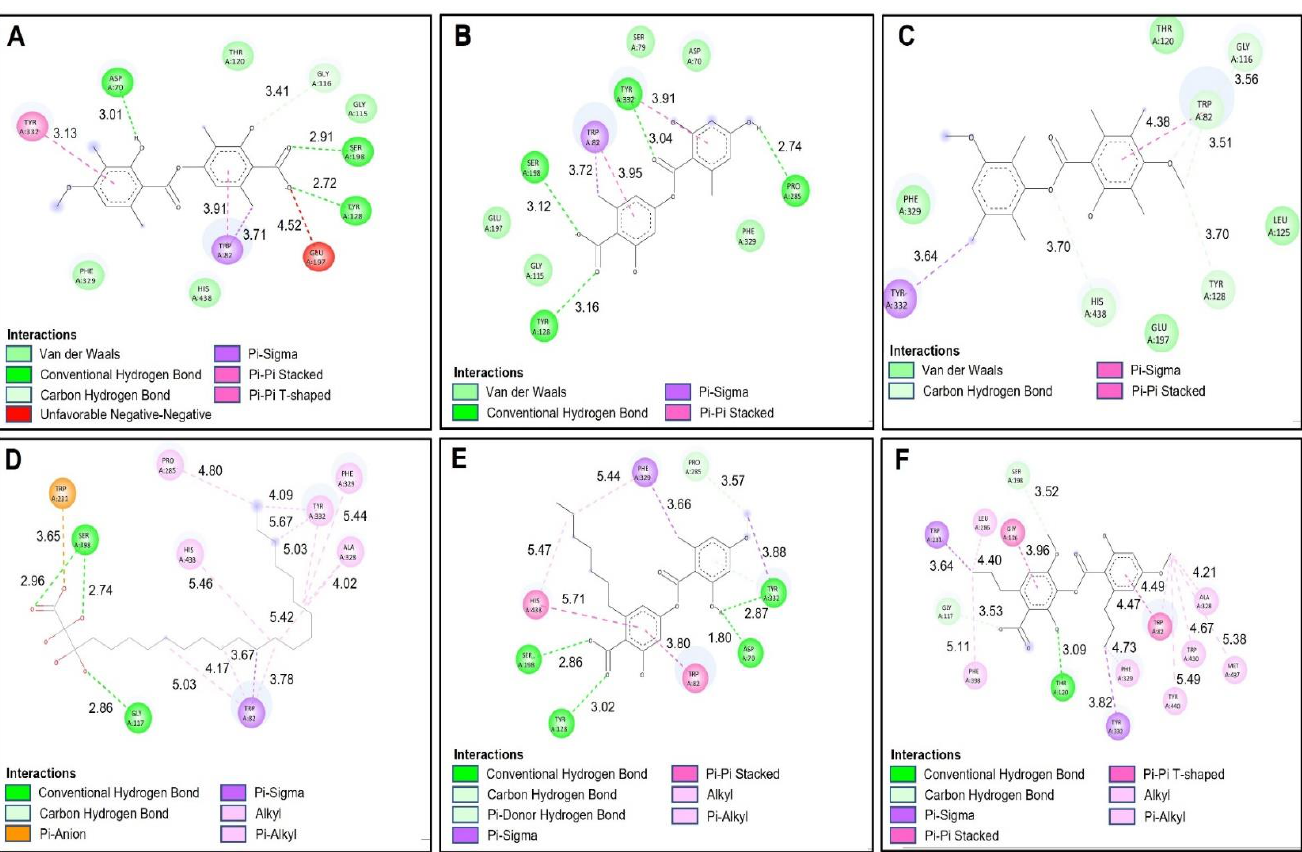
Figure 6. Two-dimensional diagram of compounds from Lecania brialmontii, Pseudephebe pubescens and Sphaerophorus globosus extracts and residues of the human butyrylcholinesterase (hBChE) catalytic site; ( A ) Barbatic acid at the catalytic site; ( B ) Lecanoric acid at the catalytic site; ( C ) Brialmontin 2 at the catalytic site; ( D ) Tetrahydroxytricosanoic acid at the catalytic site; ( E ) Sphaerophorin at the catalytic site; ( F ) Sekikaic acid at the catalytic site. Yellow dotted lines indicate hydrogen bond interactions; cyan dotted lines represent π - π interactions; magenta dotted lines represent T-shape; and red dotted lines indicate salt bridge